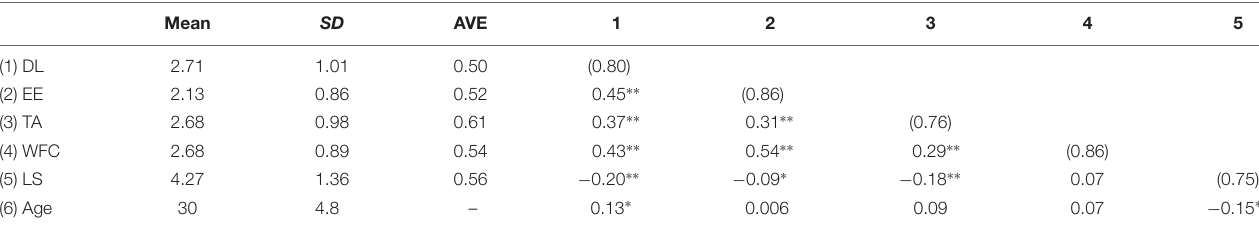
TABLE 1 | Descriptive statistics, correlation and